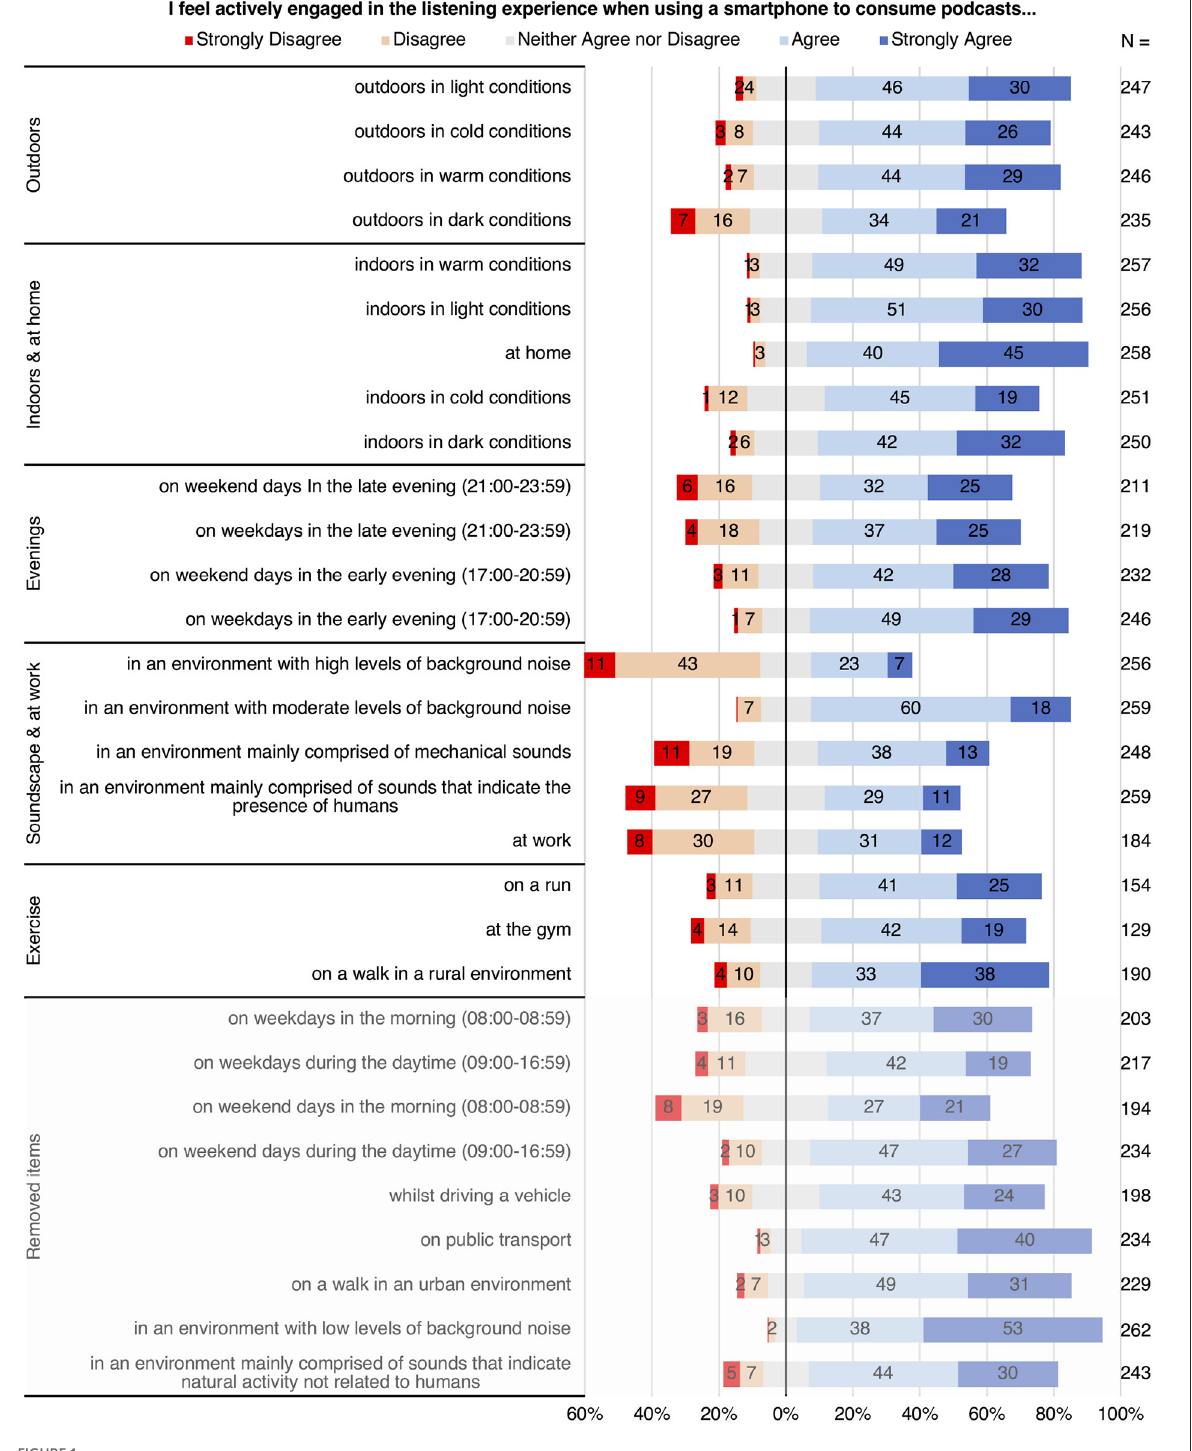
FIGURE1 Attentional engagement as a function of environmental context in podcast listening experiences scale with the factors of environmental context produced by the